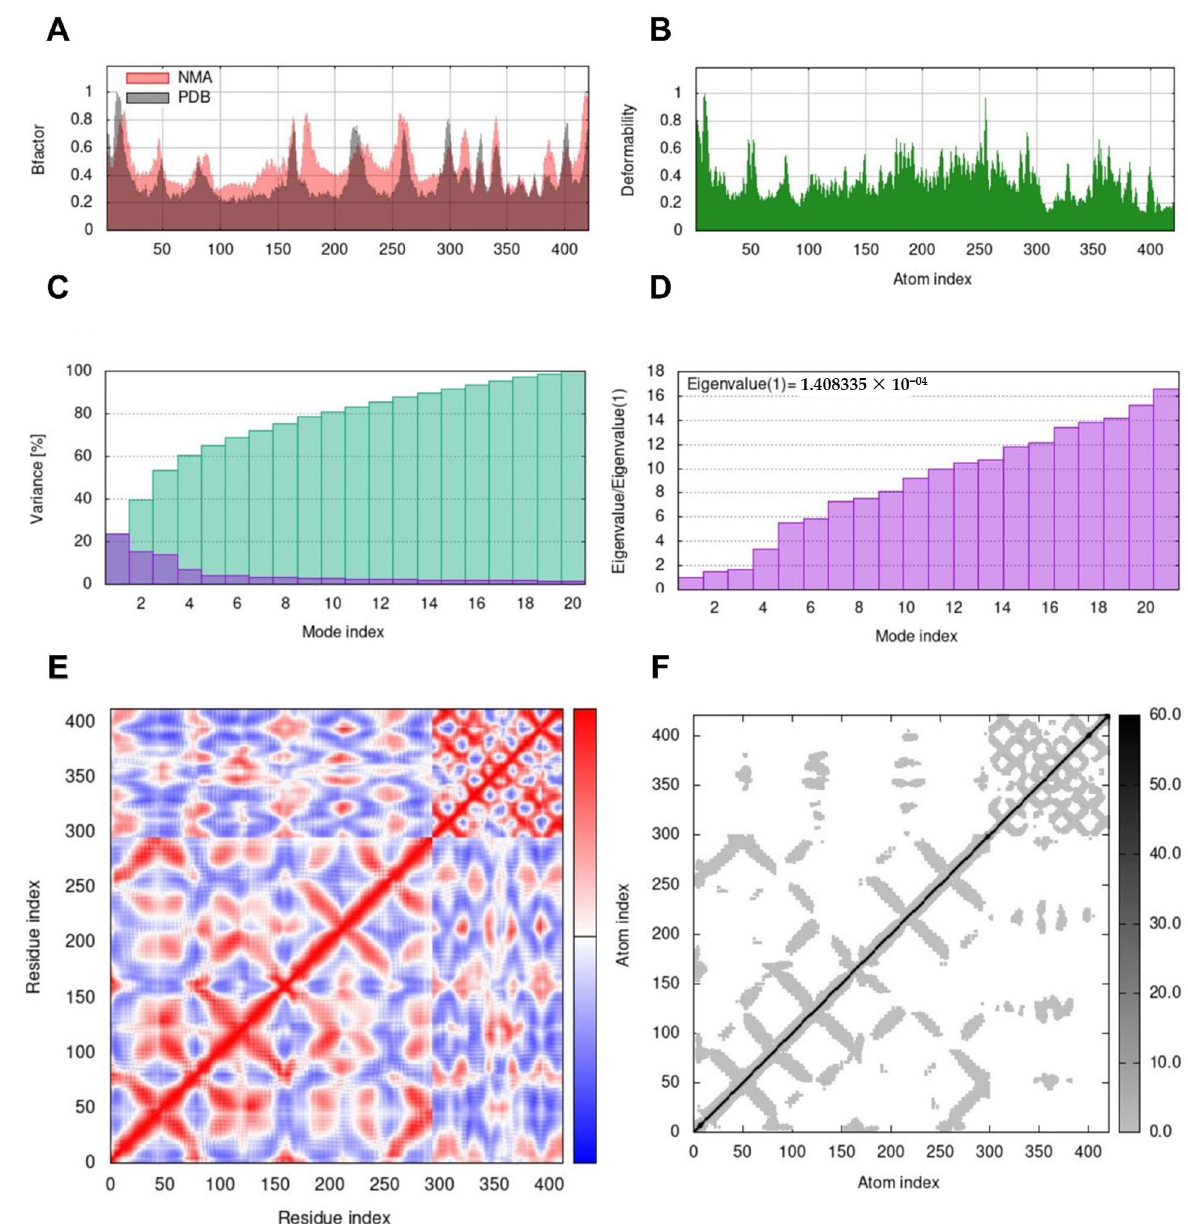
Figure 4. Molecular dynamics’ simulation of the predicted ligand–protein complex; complex stability was assessed through ( A ) deformability, ( B ) B-factor values, ( C ) variance, ( D ) eigenvalue, ( E ) the covariance of residue index, and ( F ) elastic network analysis.